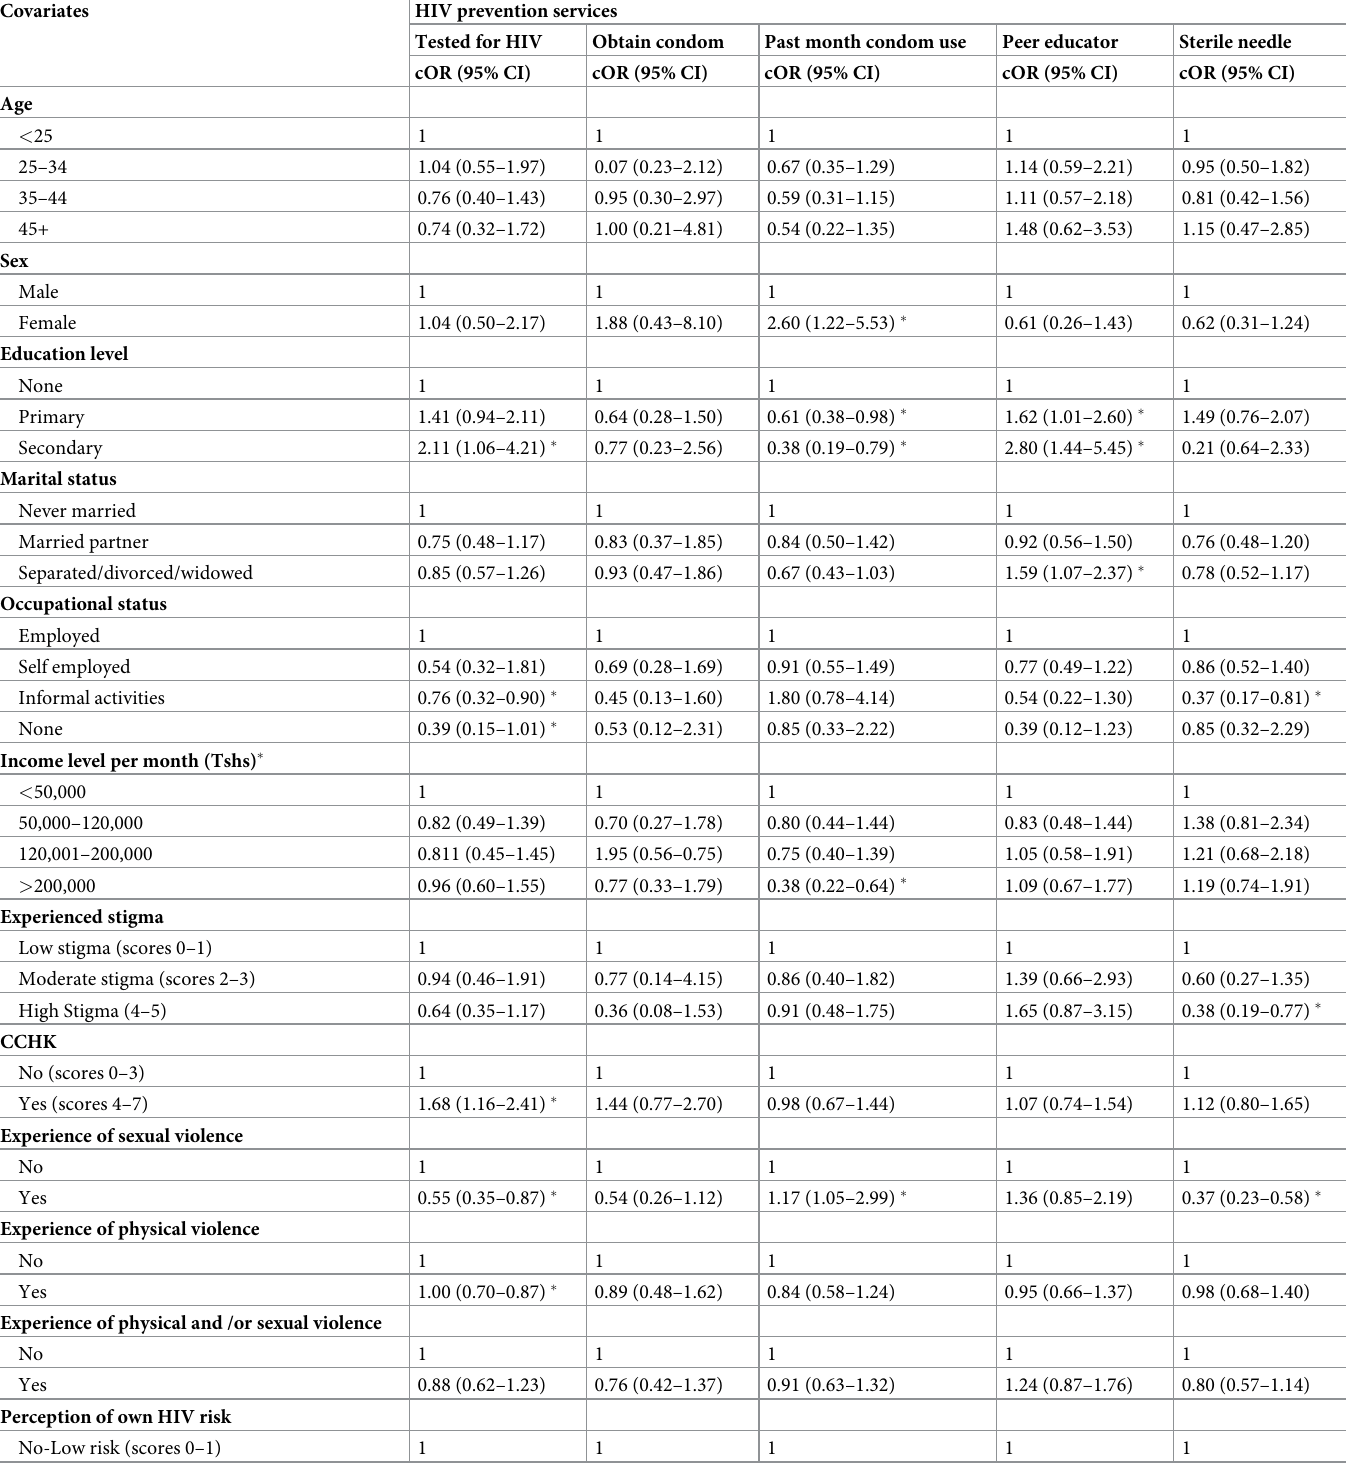
Table 4. Unadjusted analysis of the association between socio-demographic, cognitive factors and access to HIV prevention services among people who inject drugs in Dar es Salaam, 2017, (N =